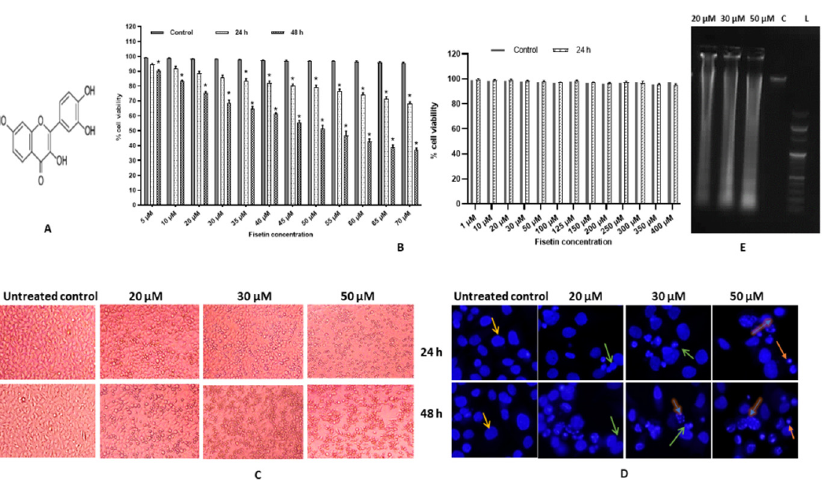
Figure 1. Cytotoxic effects of fisetin on HeLa cells. ( A ) Chemical structure of fisetin. ( B ) Graph represents dose and time-dependent decrease in cell viability of HeLa cells after treatment with fisetin [1–70 µ M] for 24 h and 48 h, respectively, whereas fisetin did not demonstrate any significant difference in the cell viability of AC-16 (normal cell line). All the assay-treated cells were compared with DMSO controls. The IC50 of fisetin was found to be 50 µM at 48 h. The data are expressed as the mean ± standard deviation of three independent experiments. Statistically significant differences are marked by asterisks: two-way ANOVA * represents p < 0.05; ( C ) Microscopic examination of treated cells: Fisetin treated HeLa cells at various concentrations [20, 30 and 50 µ M] and time points [24 h and 48 h] show the characteristic feature of rounding off of the cells, signifying apoptosis at 10X magnification. ( D ) Nuclear morphology of fisetin treated HeLa cells [20, 30 and 50 µM] shows dose-dependent increase in apoptotic index. Orange = prominent intact nuclei, green = membrane blebbing, yellow = nuclear fragmentation, green = apoptotic bodies. ( E ) HeLa cells treated with different concentrations [20, 30, 50 µM for 48 h] of fisetin were found to produce a DNA laddering pattern consistent with apoptosis. C = DMSO Control, L = DNA ladder.